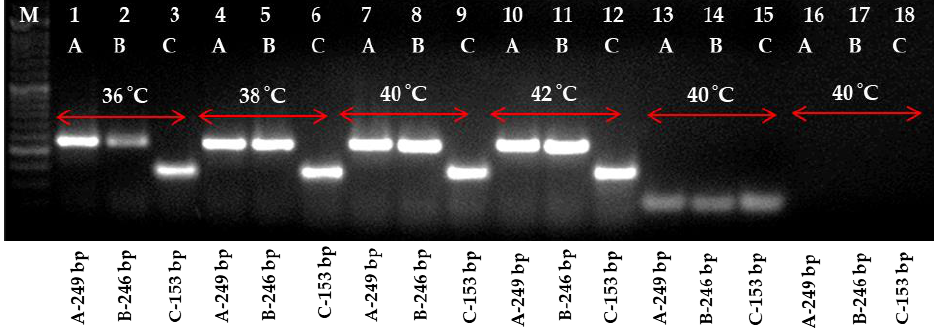
Figure 3. Primer optimization at different temperature regimes for two-step reverse transcription- recombinase polymerase amplification (RT-RPA) detection in potato leafroll virus (PLRV) infected samples. A total of 18 lanes depicted the respective target product amplification employing forward and reverse primers, viz. , LRRPAF1/R1, LRRPAF2/R2 and LRRPAF3/R3. The primers sets are shown over each lane along with the corresponding expected amplified product. A 100 bp ladder (Lane M) along with a healthy control (Lanes 13, 14 and 15) and a negative (water) control (lanes 16, 17 and 18) are also included for the accuracy of the results.